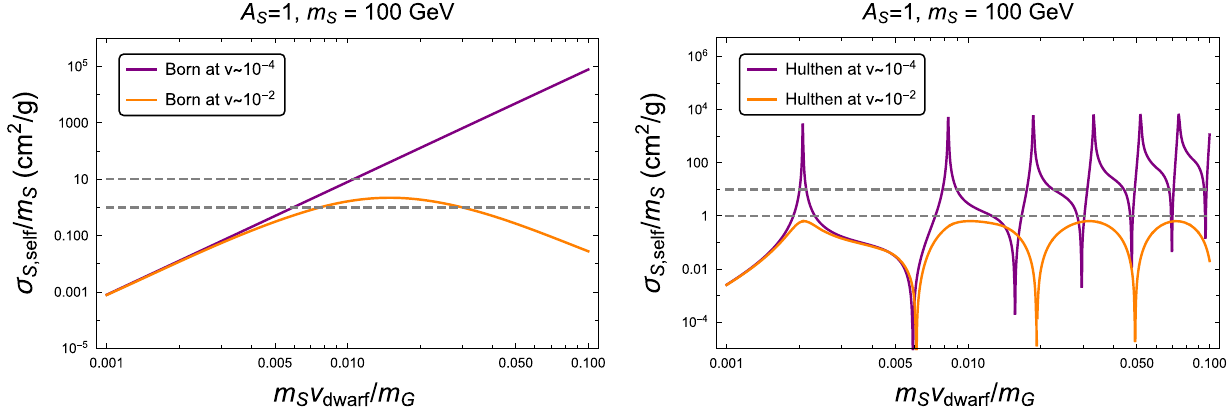
Fig. 2 Born cross section (left) and non-perturbative cross section (right) for the self-scattering of scalar dark matter. We took A S = 1 and m S = 100GeV. We made the Hulthén potential approximation for the non-perturbative cross section Fig. 3 The DM self-scattering cross section divided by DM mass as a function of the DM velocity, depending on the spins of dark matter, s = 1 / 2 , 0 on left and right. We have chosen A DM = 1 and m DM v dwarf / m G = 0 . 1, at dwarf galaxies with v dwarf = 10 − 4